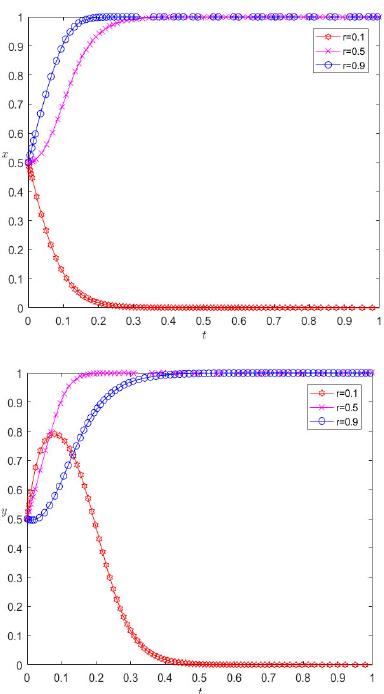
Figure 5. Evolution results of changing the income distribution ratio.